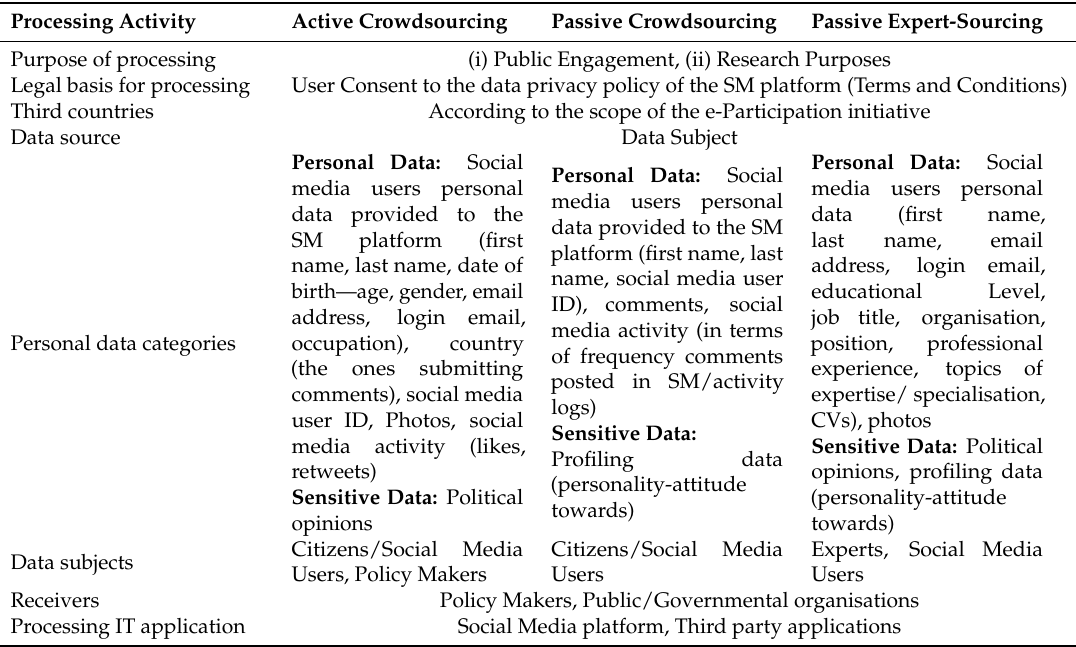
Table 1. Processing activities of e-Participation